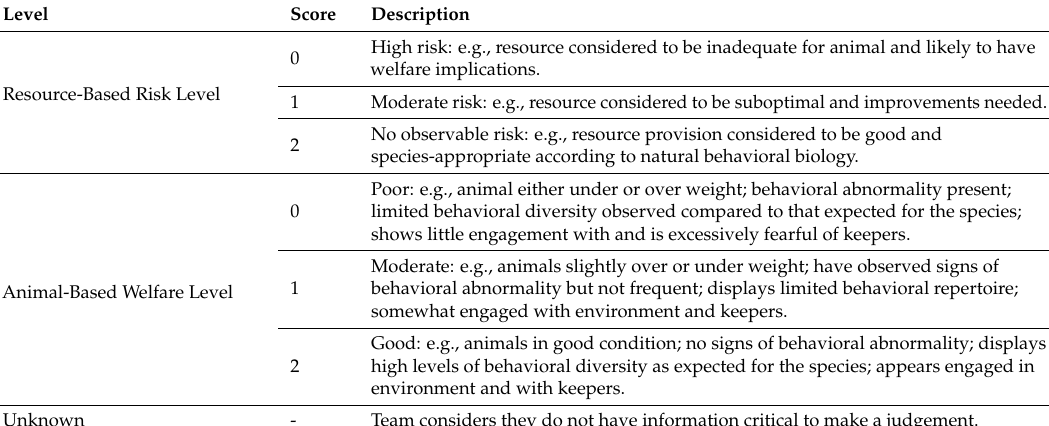
Table 2. Grading system reproduced from Sherwen et al. (2018) [1]. Overall welfare score determined by summation and determination of percent out of the maximum score possible. Welfare threshold to be aimed for is 60% as suggested by Sherwen et al.